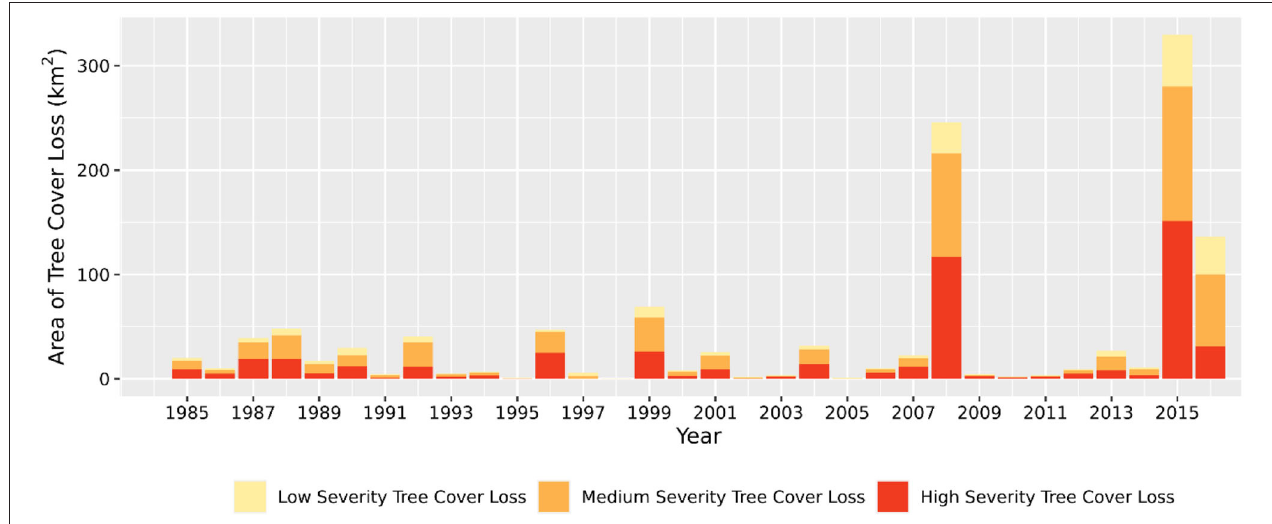
FIGURE 7 | Interannual variability in fire-induced tree cover loss showing sudden increases in tree cover loss by medium–high severity fires in 2008, 2015, and 2016 across blue oak woodlands. Percent tree cover area on y-axis is the area of change expressed as a percentage of the original tree cover area in